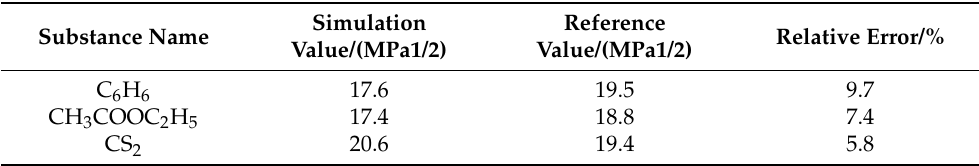
Table 1. Simulation value of solubility parameters of each substance and literature value [28] (P 0 = l atm, 296.15